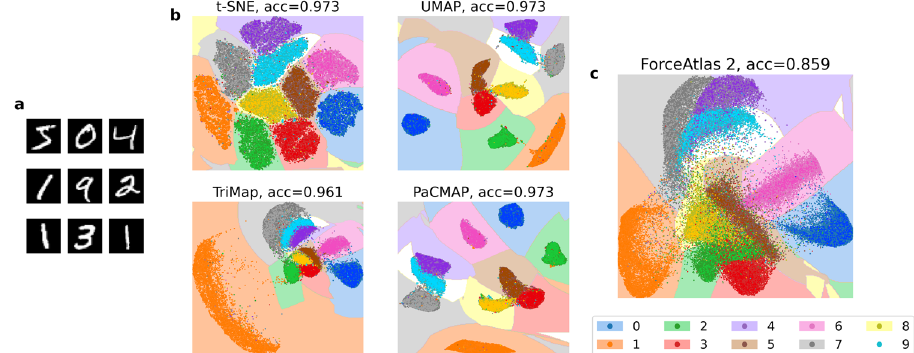
Fig. 2 Measuring local structure preservation with SVM supervised classi fi cation. a Nine samples out of the 70,000 total samples from the MNIST dataset. b DR results from four different methods using the MNIST dataset. acc indicates test accuracy score. The accuracy score and decision boundaries were created by an SVM classi fi er. Here, 90% of the data were used for training, 10% for testing. c Results of ForceAtlas2 on the MNIST dataset, following the same procedures. ForceAtlas2 demonstrates inferior local structure preservation compared to the other